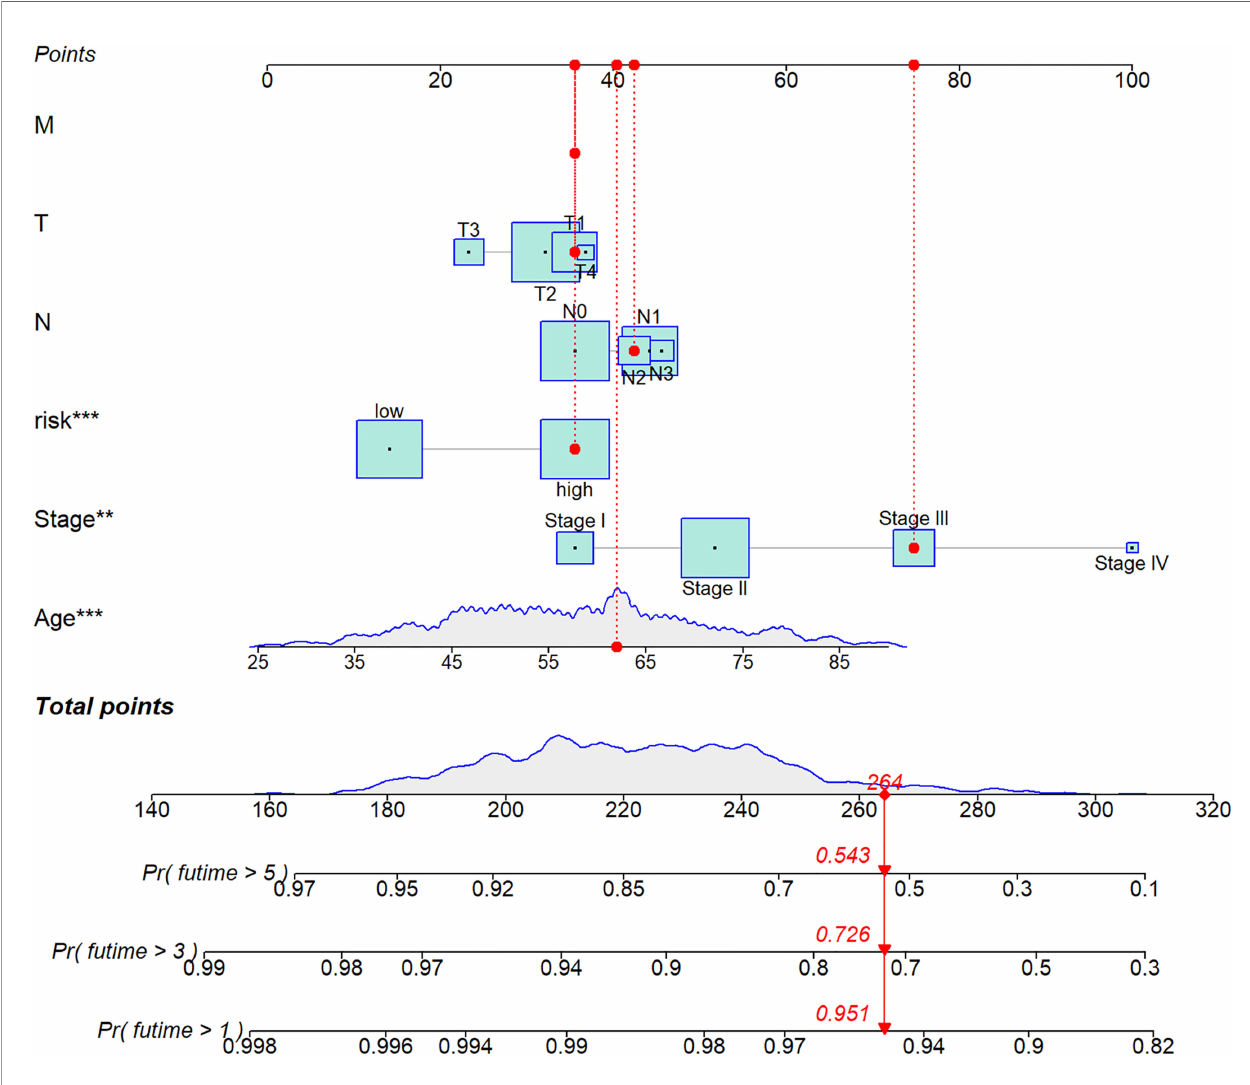
FIGURE 7 | A nomogram was established integrating the RS, Age, Stage, T, M, N, for predicting 1-, 3-, and 5-year survival outcomes of BC. To calculate survival probability, identify patient values on each axis and then for each draw a vertical line upward to the points axis. Add the points for all variables and locate this sum on the total points line. * P < 0.05, ** P < 0.01, and *** P <